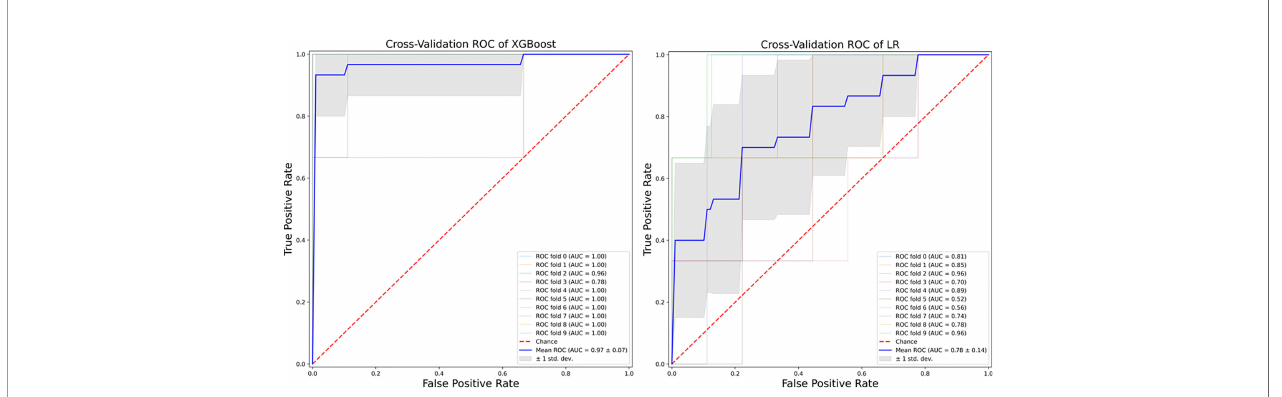
FIGURE 3 | A diagnostic calibration has been plotted for XGBoost after 10-fold isotonic calibration; DAPSA remission roughly happened with an observed relative frequency consistent with the forecast value, showing a suitable calibration curve. DAPSA, Disease Activity in Psoriatic Arthritis; XGBoost, eXtreme Gradient Boosting.